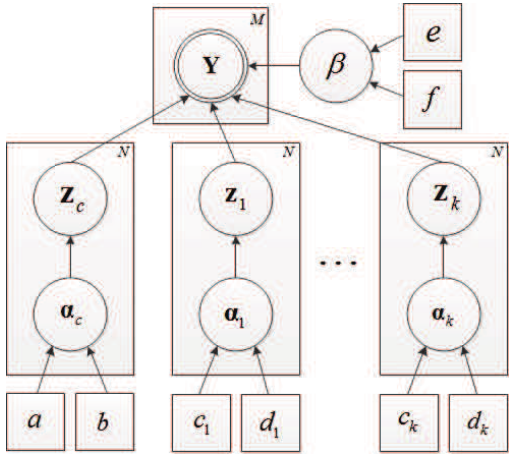
Figure 4. Graphical model for the JSM-1 model. Doubly circled node represents measurements, while single circled nodes represent hidden variables. Nodes denoted with squares correspond to hyperparameters. The directed edges represent the dependencies among the